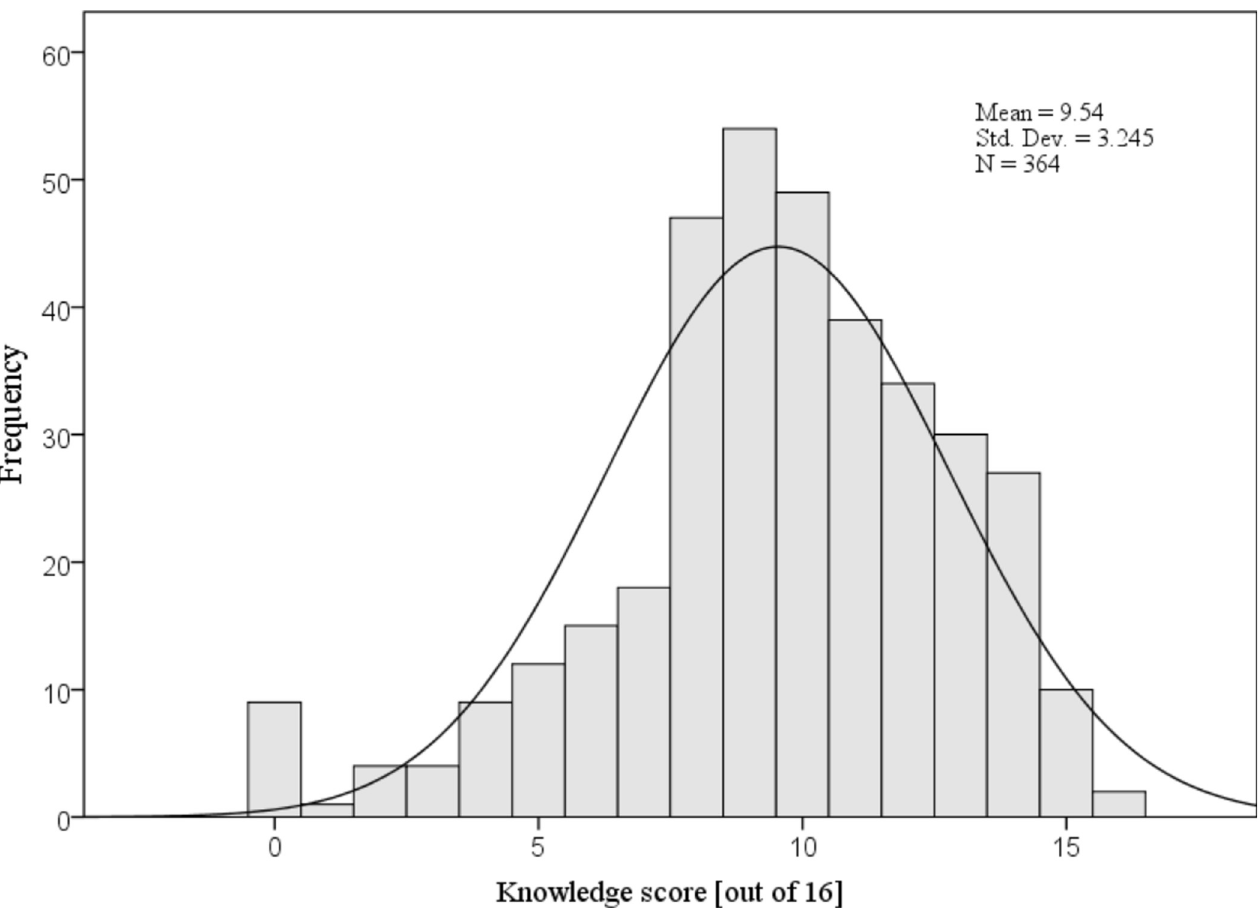
Fig 1. Distribution of primary care physicians’ overall mean knowledge scores about travel vaccines and malaria chemoprophylaxis (N = 364).